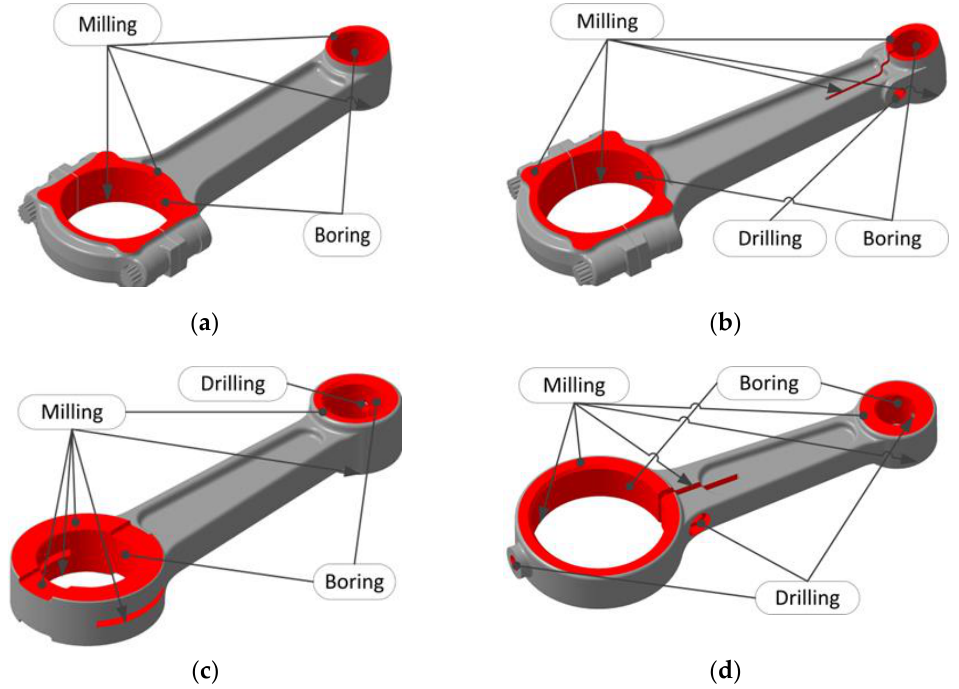
Figure 1. The designs of connecting rods with machined surfaces: ( a ) Detachable connecting rods; ( b ) Detachable clip connecting rods; ( c ) One-piece connecting rods; ( d ) One-piece clip connecting rods.